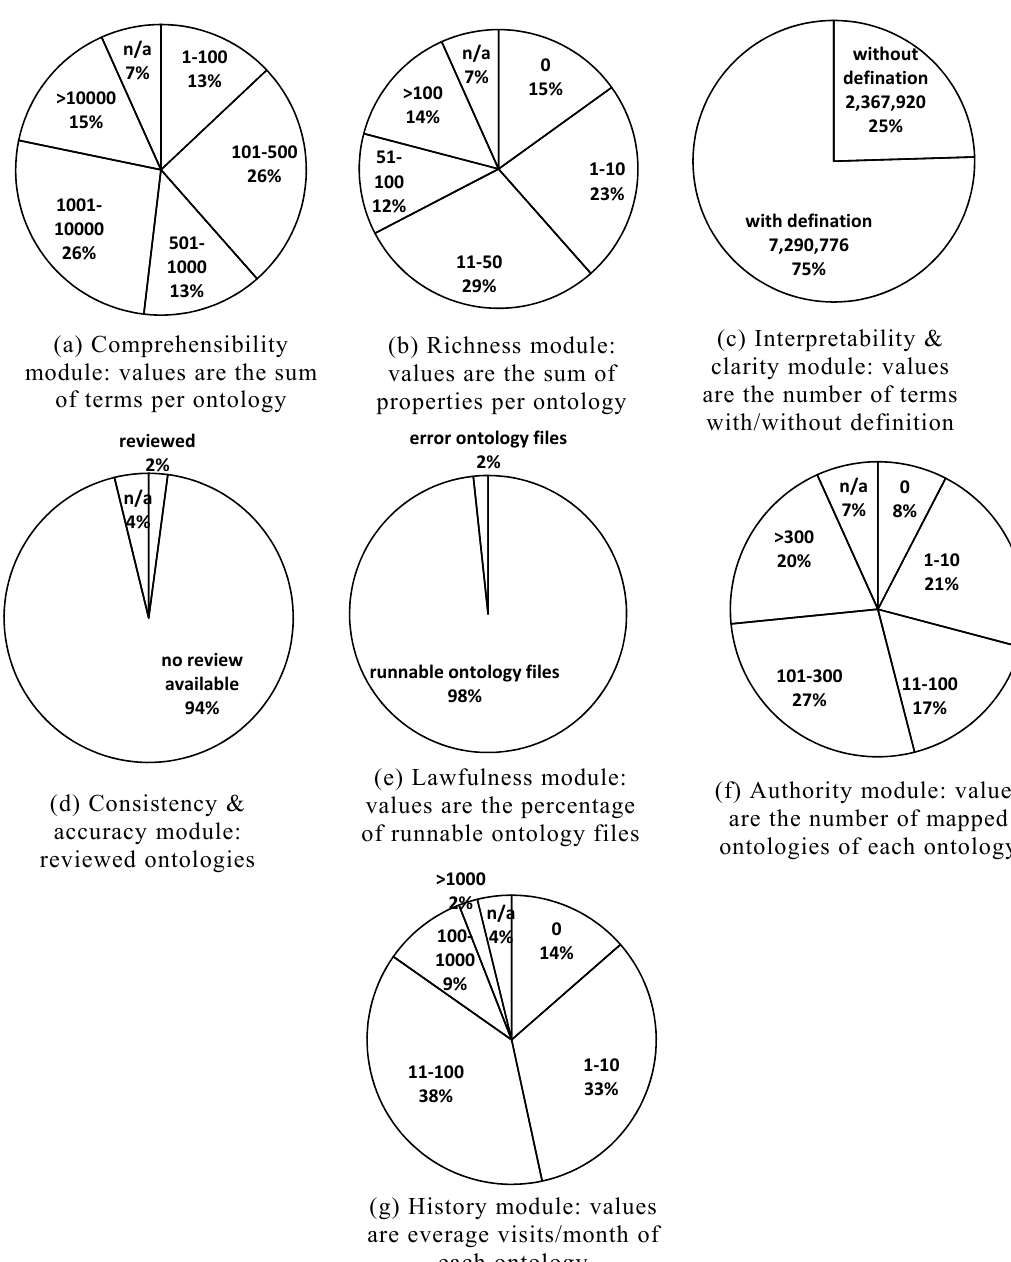
Figure A1. Quality characteristics of selected ontologies for nutritional